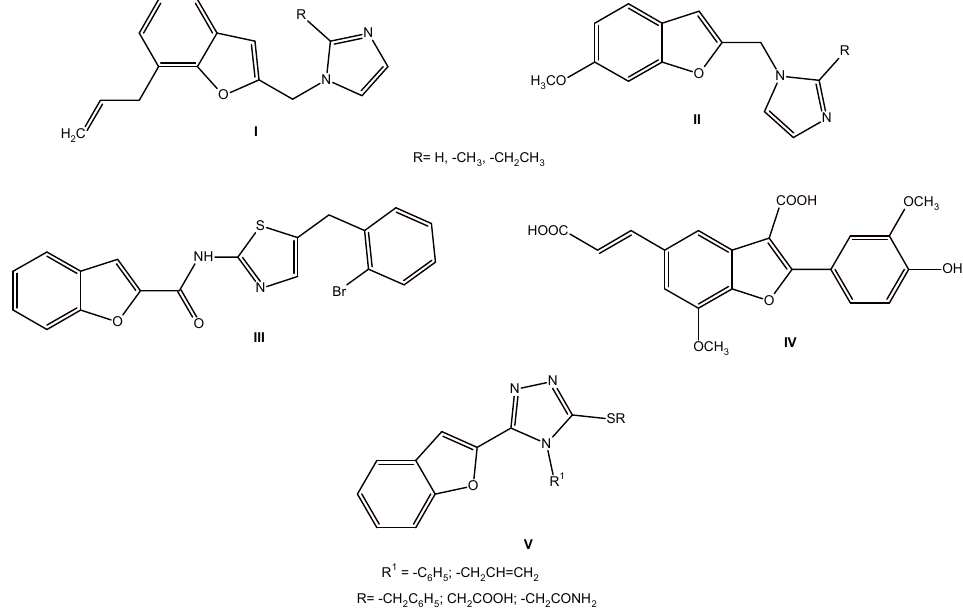
Figure 2. Structures of synthetic benofuran derivatives I – V with anticancer activity [7].